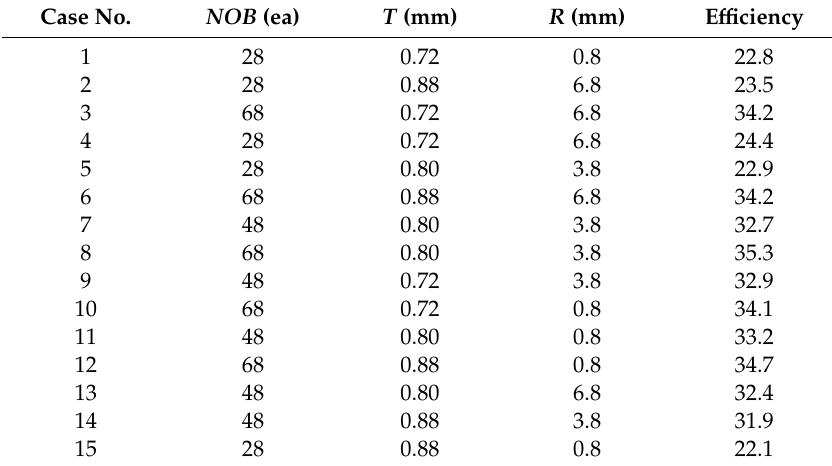
Table 4. Pump e ffi ciency obtained by RSM.